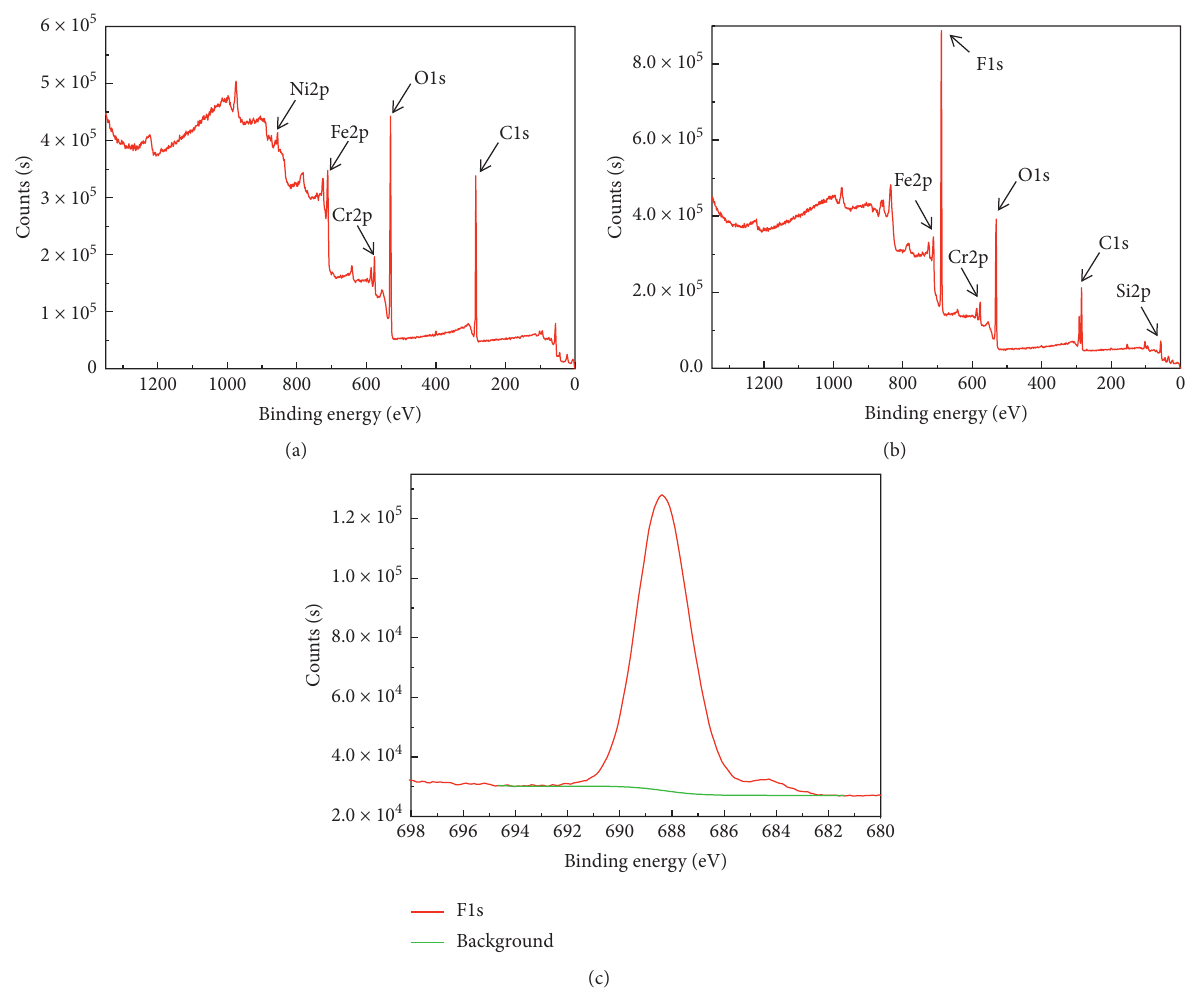
Figure 7: XPS diagrams of S1: (a) before fluorination, (b) after fluorination, and (c) F1s element.